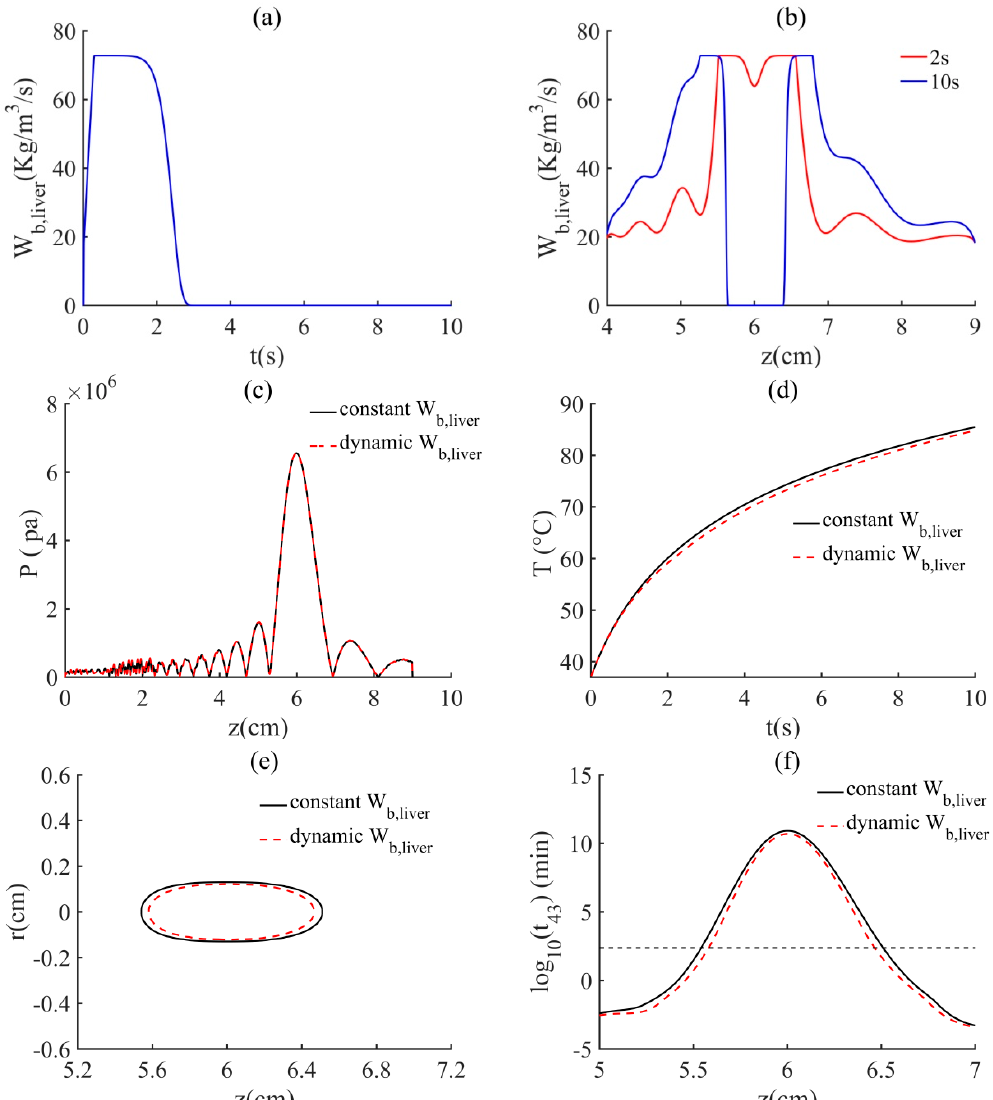
Figure 8. ( a ) Dynamic blood perfusion change with time. ( b ) Axial profile of dynamic blood perfusion at t = 2 s and 10 s. The effects of dynamic blood perfusion on: ( c ) p and ( d ) T at the ultrasonic focus and ( e ) thermal damage zone; ( f ) Q 43 at t = 10